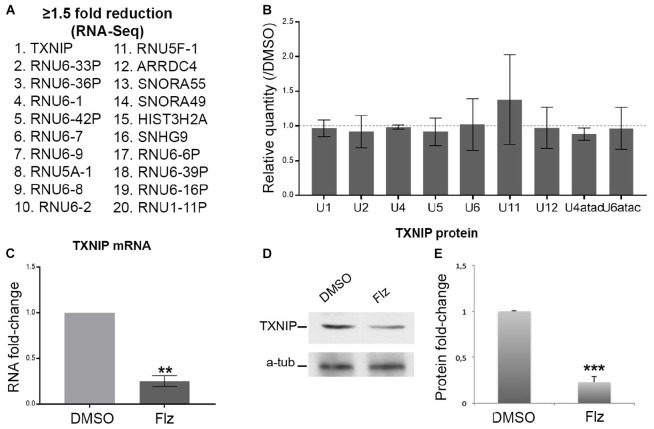
Effects of flunarizine on the expression of target RNAs in SMA patient cells. (A) The twenty most reduced genes identified by RNA sequencing after 4-hour of flunarizine treatment are listed. (B) The snRNA levels are determined by RT-qPCR and the relative amount is presented as fold-change of the flunarizine (Flz) treatment compared to DMSO (arbitrary unit of 1). The 5 S and 5.8 S are used as controls for normalization as described previously (Sapaly et al., 2018). Error bars indicate the S.E.M (five independent experiments, Student’s t-test, not significant). (C) Quantitative RT-PCR analysis confirms that flunarizine reduces TXNIP mRNA expression in SMA cells. RPL13 and SDHA are used as internal controls for normalization (Three independent experiments, Student’s t-test, **P < 0.01). (D) Immunoblot analysis using specific antibodies shows that flunarizine reduces the protein levels of TXNIP. (E) Columns represent the ratio of the protein over α-tubulin that served as the loading control and normalized to the ratios obtained following the DMSO treatment (arbitrary unit of 1) (four independent experiments, Student’s t-test, ***P < 0.001).